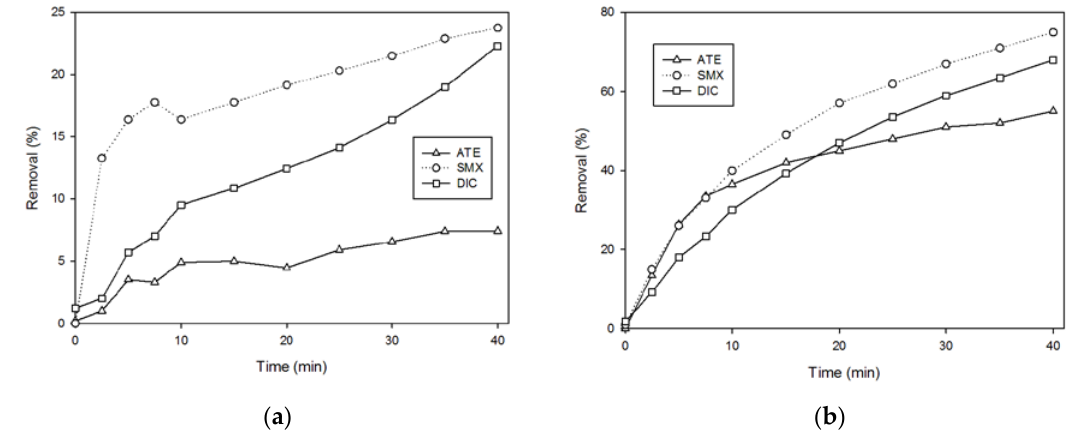
Figure 4. Removal efficiencies of triple pharmaceuticals in a 1 L batch reactor with a graphite electrode and a ( a ) 1-cell or ( b ) 5-cell system ([Phar.] 0 = 100 µM, [NaCl] = 0.01 M, I = 0.5 A).